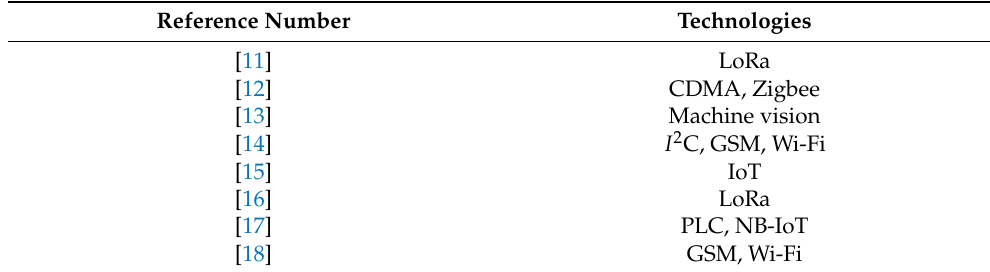
Table 1. Technologies of